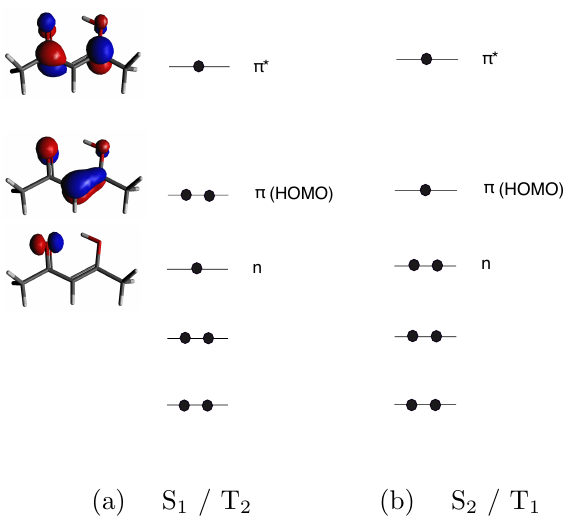
Figure 1. Electronic configurations of the S 1 , T 2 ( a ) and S 2 , T 1 ( b ) excited states of acetylacetone with the plots of the three outer valence molecular orbitals calculated with